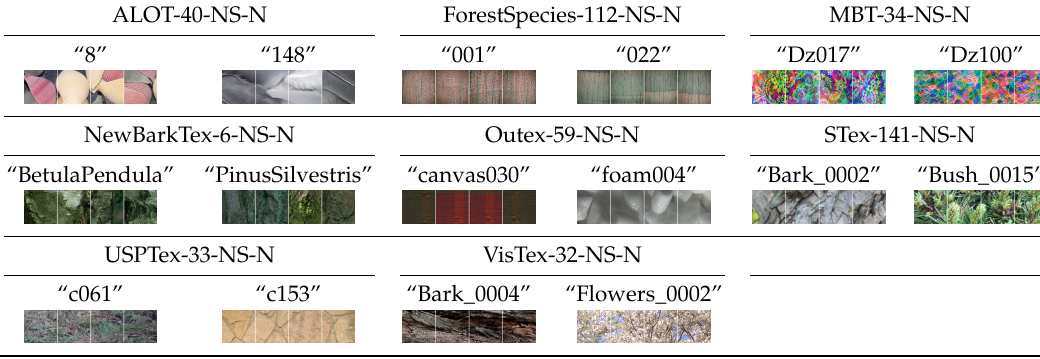
Figure 2. Group #2: Non-stationary textures acquired under steady imaging conditions (Section 3.2.2).